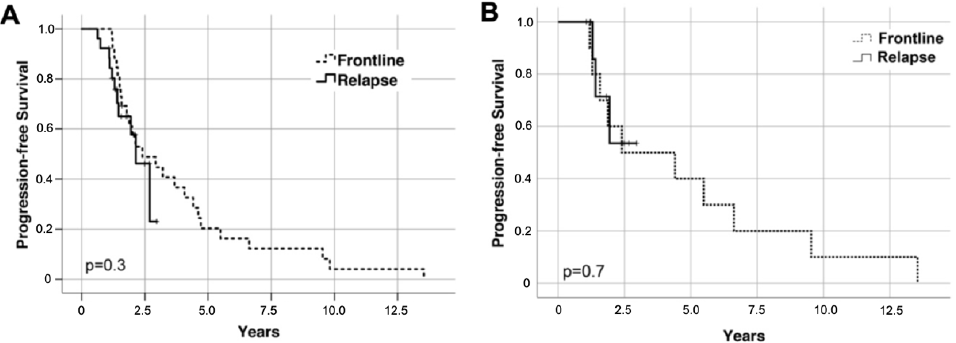
Figure 3. Kaplan – Meier plots of progression-free survival (PFS) in patients ( A ) achieving at least equal and ( B ) better depth of response at the time of salvage HDCT/ASCT as before frontline HDCT/ASCT PFS was calculated from ASCT.